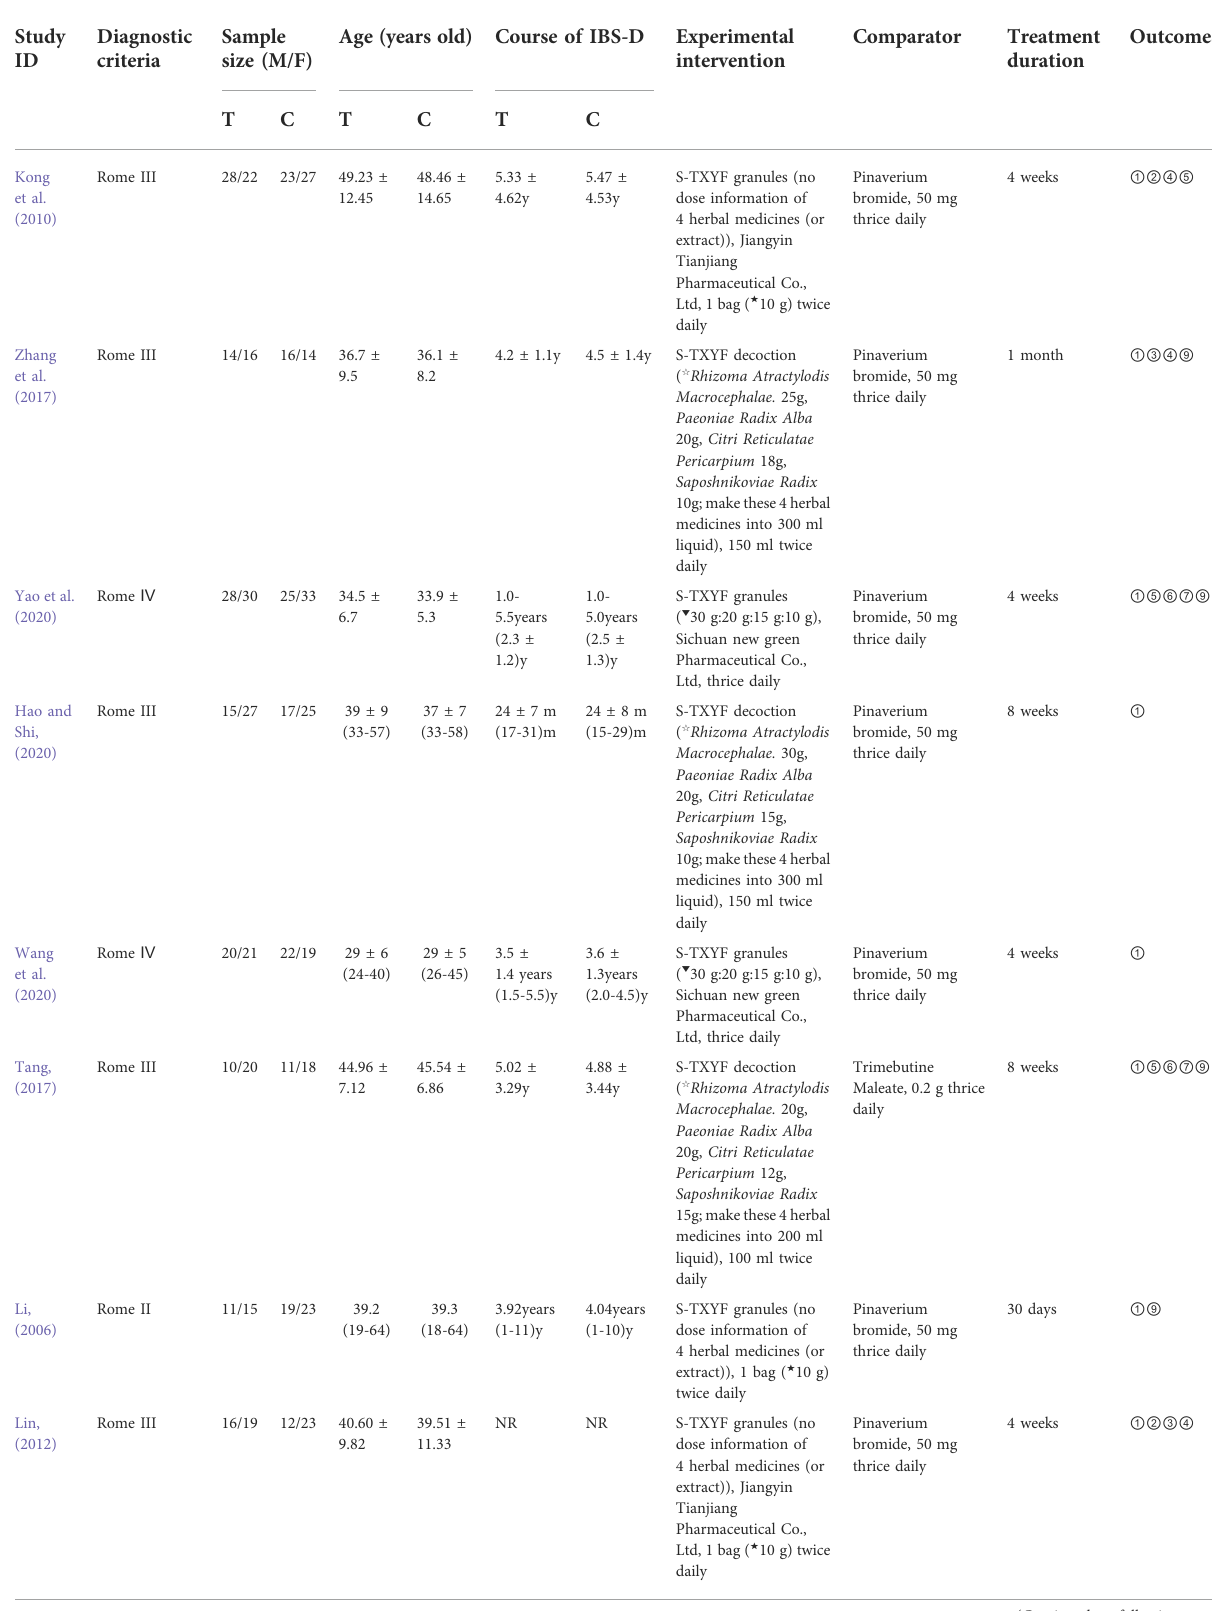
TABLE 1 Characteristics of the included 11 randomized controlled